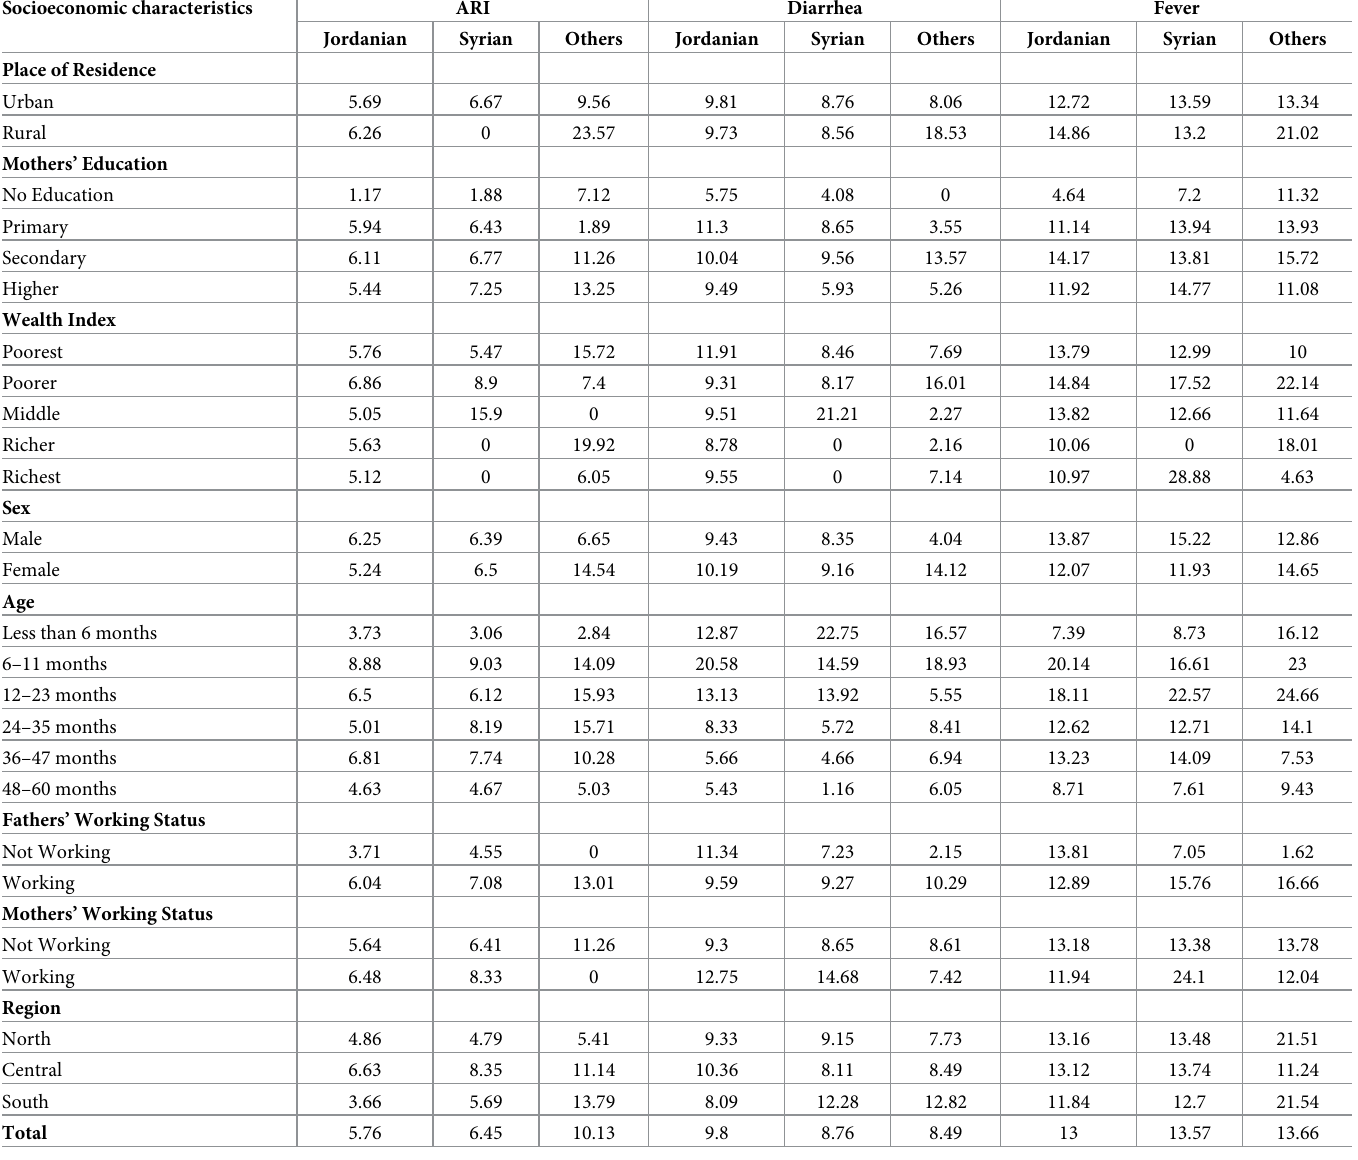
Table 3. Prevalence of acute respiratory infection, diarrhea and fever by socioeconomic characteristics among under-five children in Jordan, 2017–18. Socioeconomic